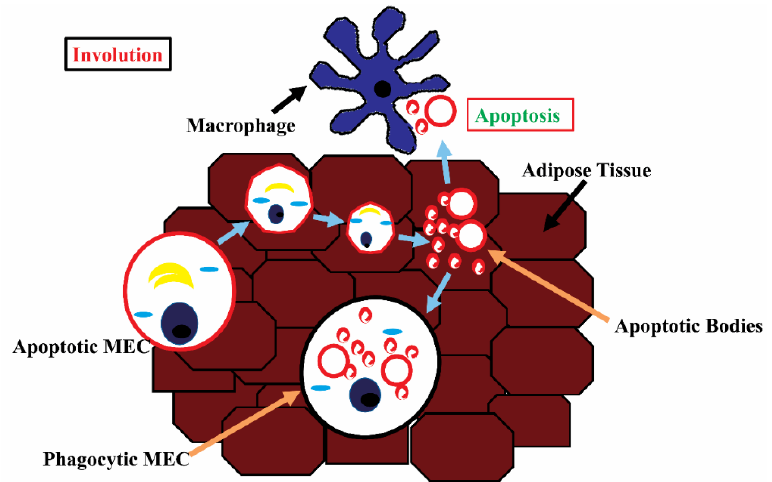
Figure 6. Schematic diagram illustrating the involutory bovine mammary gland containing mac- rophage and apoptotic and phagocytic MECs. macrophage and apoptotic and phagocytic